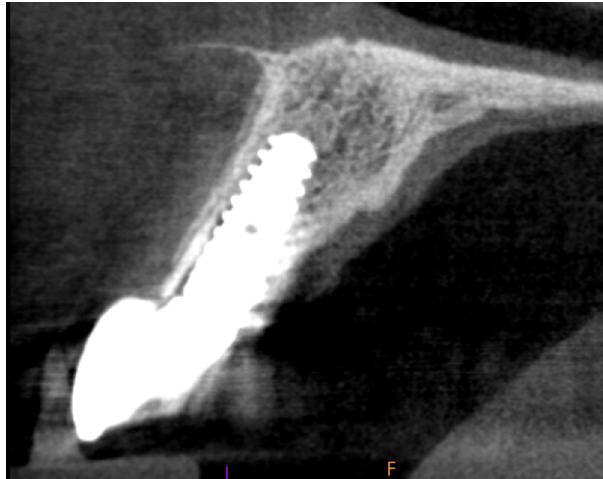
Fig. 7. Four year follow up section of CBCT showing intact shield.